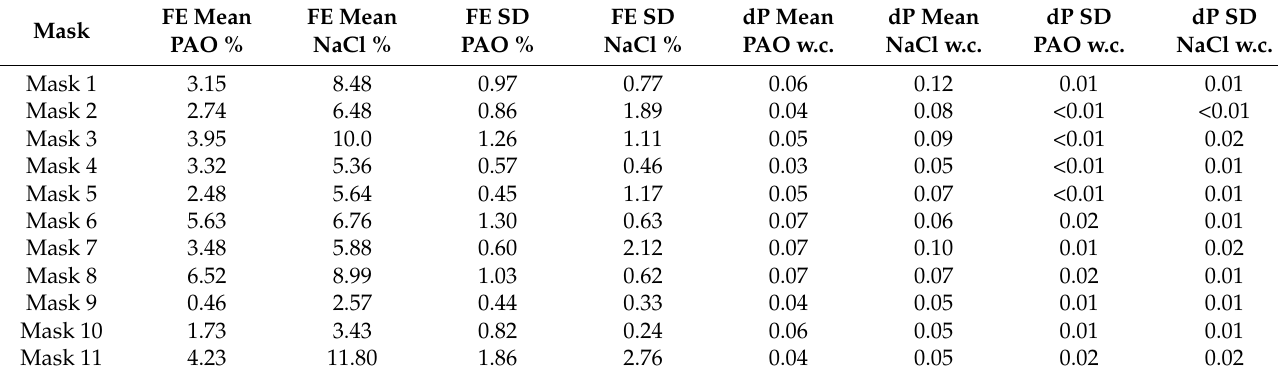
Table 2. Filtration Efficiency, Differential Pressure, and Q Factor Means and Standard Deviations.